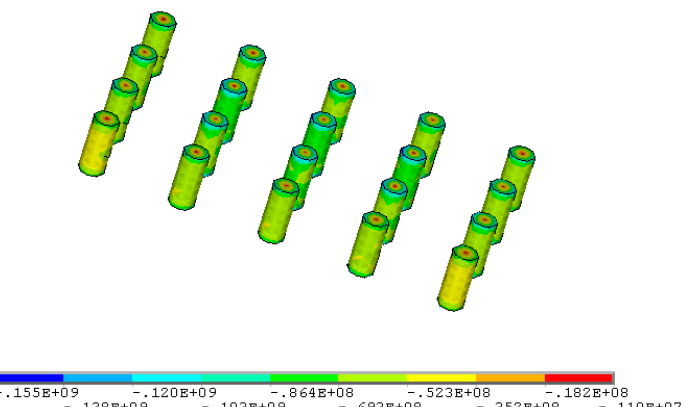
Figure 33. Minimum principal stress distribution of scheme 7 pillars at 1480 mL (parameters of scheme 7: stope height 4.5 m, pillar diameter 2 m, pillar spacing 6 m, pillar row spacing 7 m).